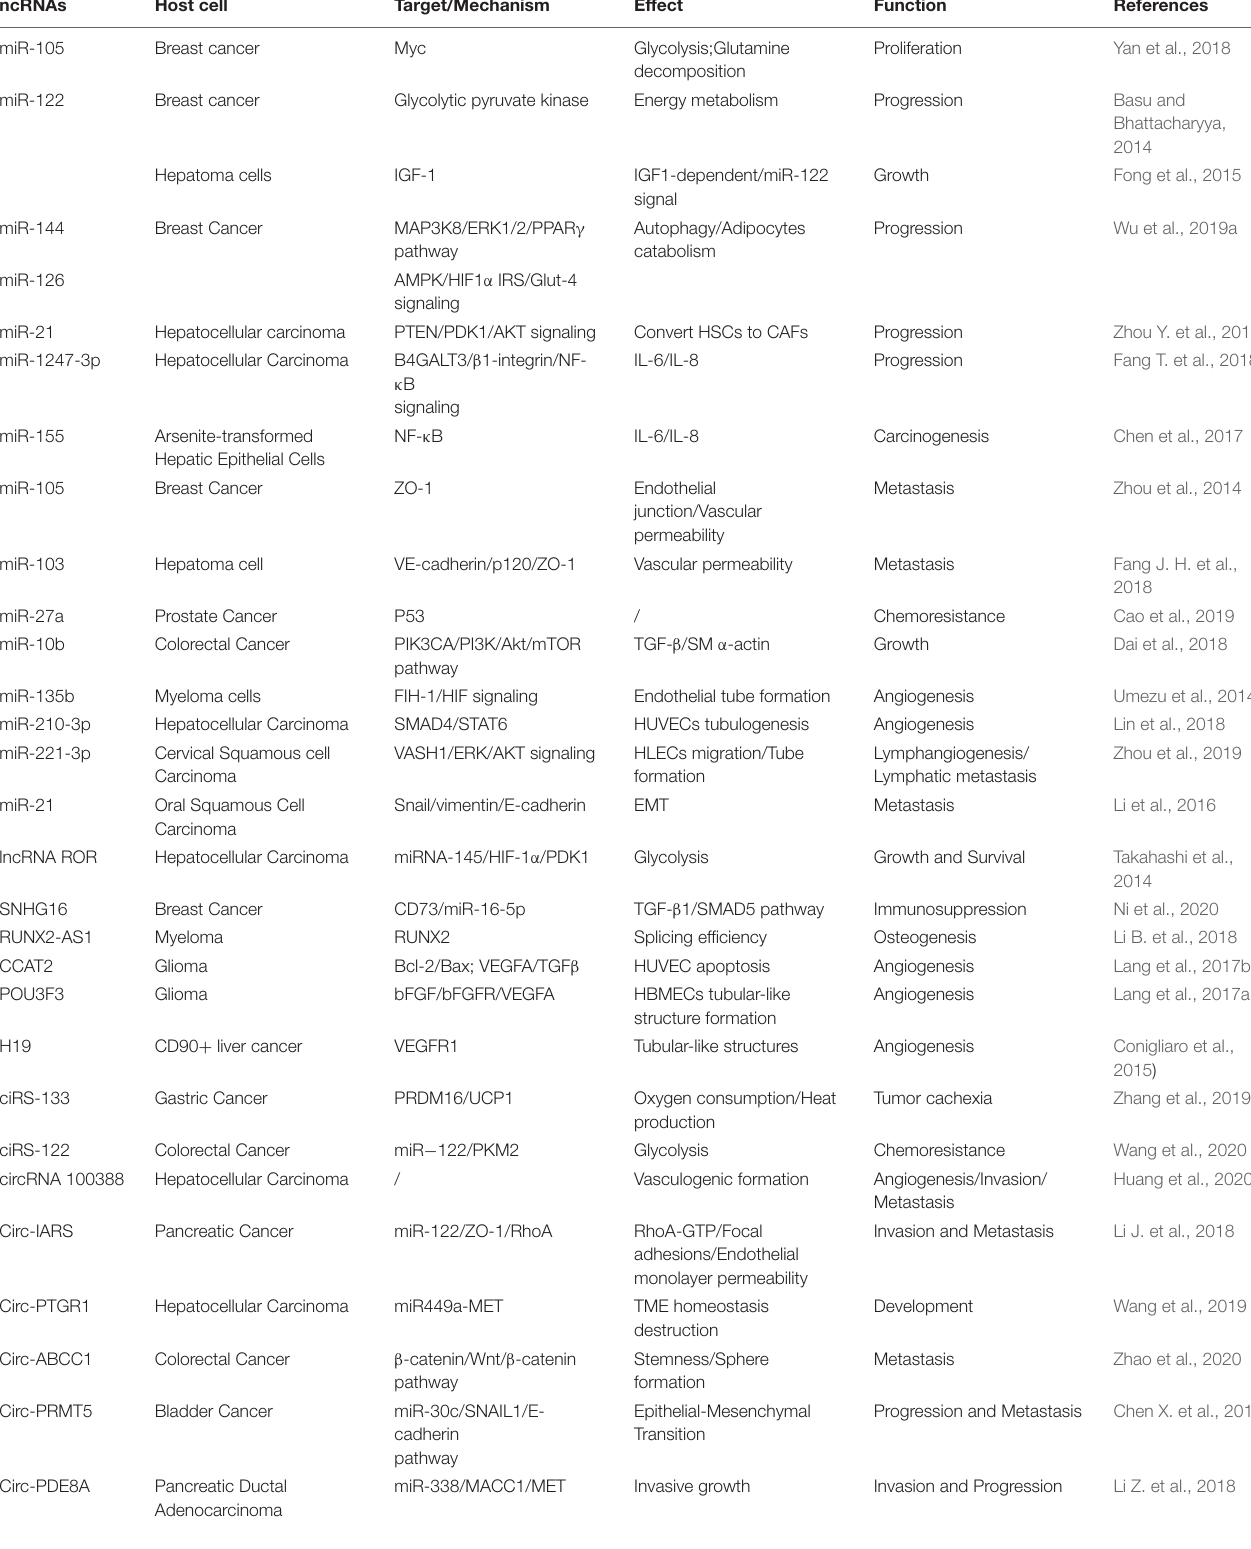
TABLE 1 | Roles of tumor-derived exosomal ncRNAs in modulating the